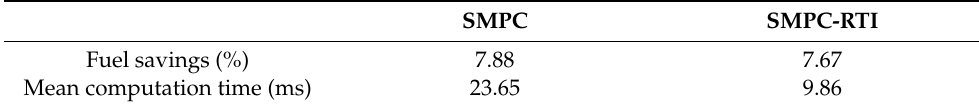
Table 7. Real-time performance of ECs using two speed controllers: SMPC and